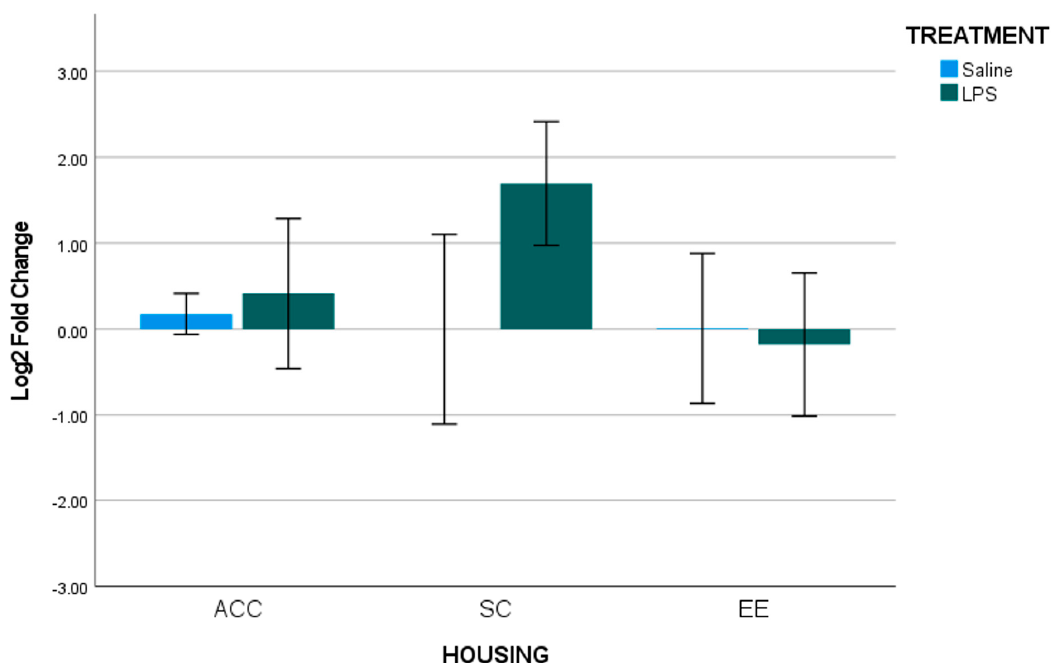
Figure 2. B2 SINE expression for Standard vs. Enriched and Standard vs. Social Control Housing in the DST. Standard (Saline: n = 12, LPS: n = 10), Enriched (Saline: n = 12, LPS: n = 14), Social Control (Saline: n = 13, LPS: n = 15). A two-way ANOVA revealed there were no simple main effects from housing or treatment. There were no statistically signi fi cant interactions. (* p ≤ 0.05, a p < 0.05, main e ff ect of treatment, b p < 0.05, main e ff ect of housing; mean ± SEM). The nucleus accumbens was selected due to involvement in stress-related alterations along with being implicated in observed schizophrenic disturbances [80]. In NAcc, there was no interaction (F (2, 75) = 0.889, p = 0.416), no e ff ect of treatment (F (1, 75) = 0.400, p = 0.529), and no e ff ect of housing (F (2, 75) = 0.889, p = 0.416) (Figure 3).